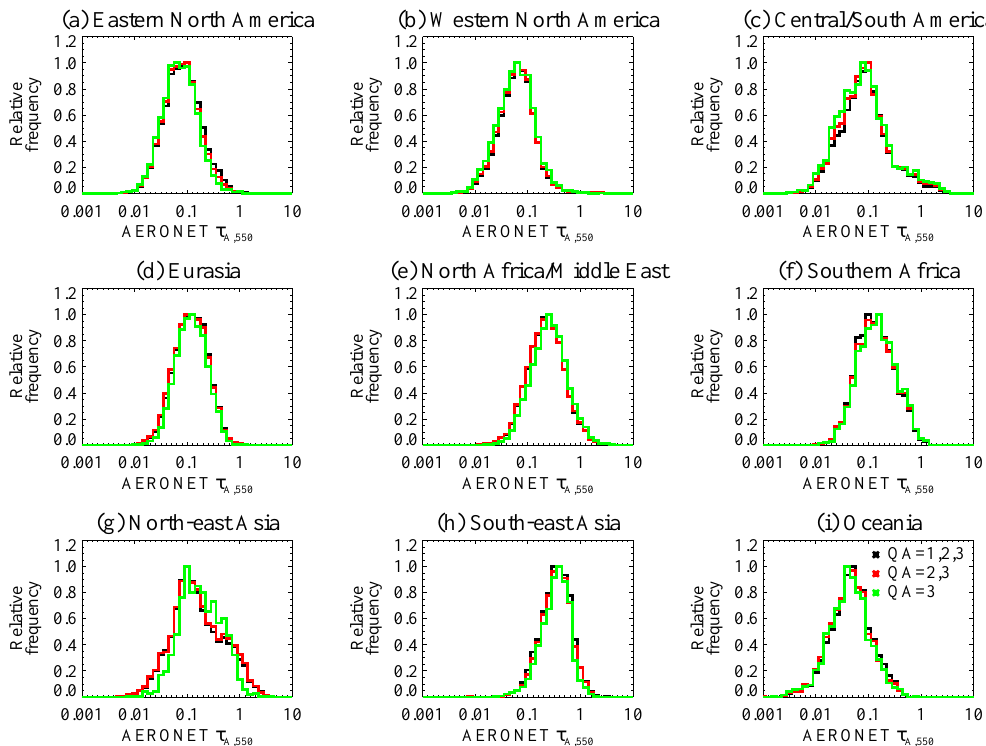
Fig. 3. Histograms of AERONET AOD at 550nm obtained from SeaWiFS-AERONET matchups. Each subfigure shows a composite from sites in different regions, as defined in Fig. 1. Black lines show histograms for matchups with all SeaWiFS QA permitted, red lines those matchups obtained using QA=2 or QA=3 retrievals only, and green lines those matchups using QA=3